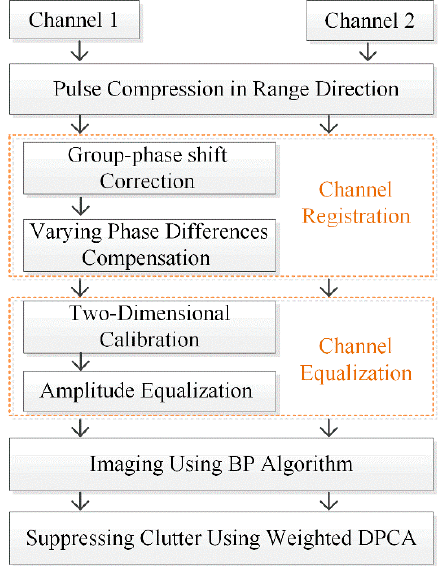
Figure 2. The flowchart of a dual-channel circular synthetic aperture radar (CSAR) ground moving target indication (GMTI) method. BP: back-projection, DPCA: displaced phase center antenna.